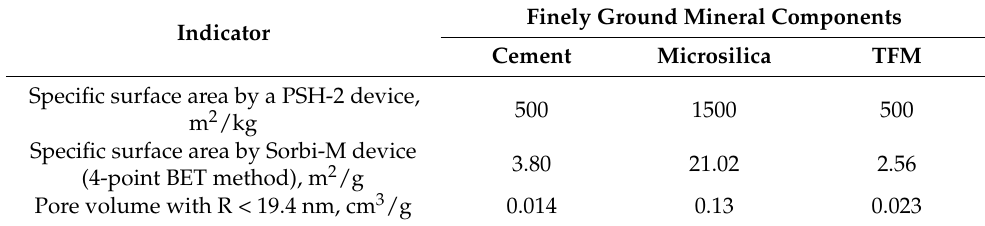
Table 4. Properties of finely ground components.